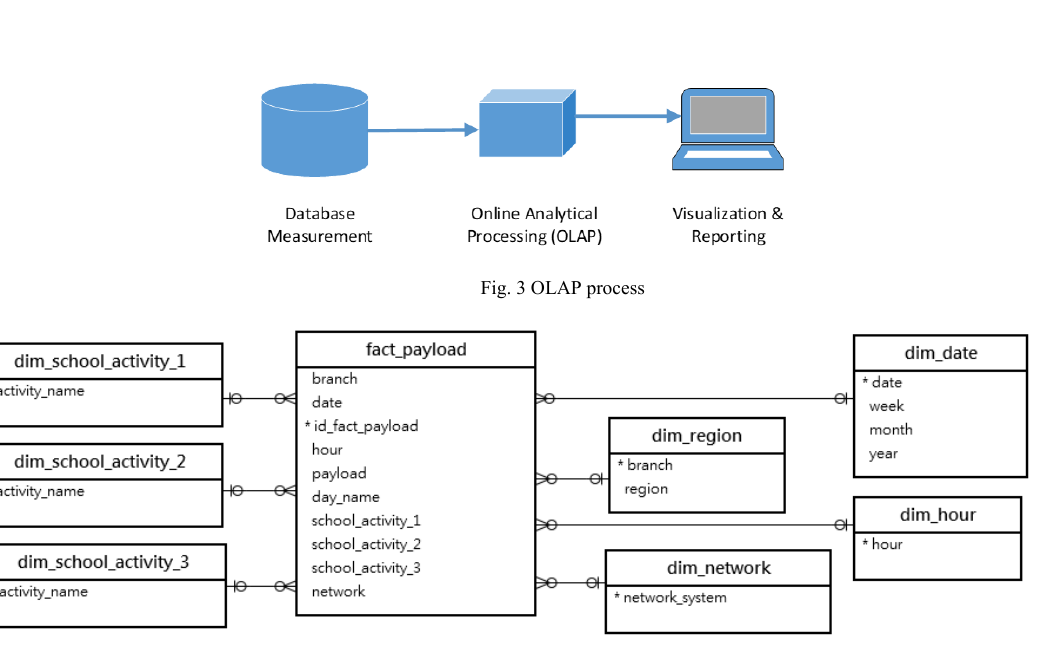
Fig. 4 Multidimentional scheme